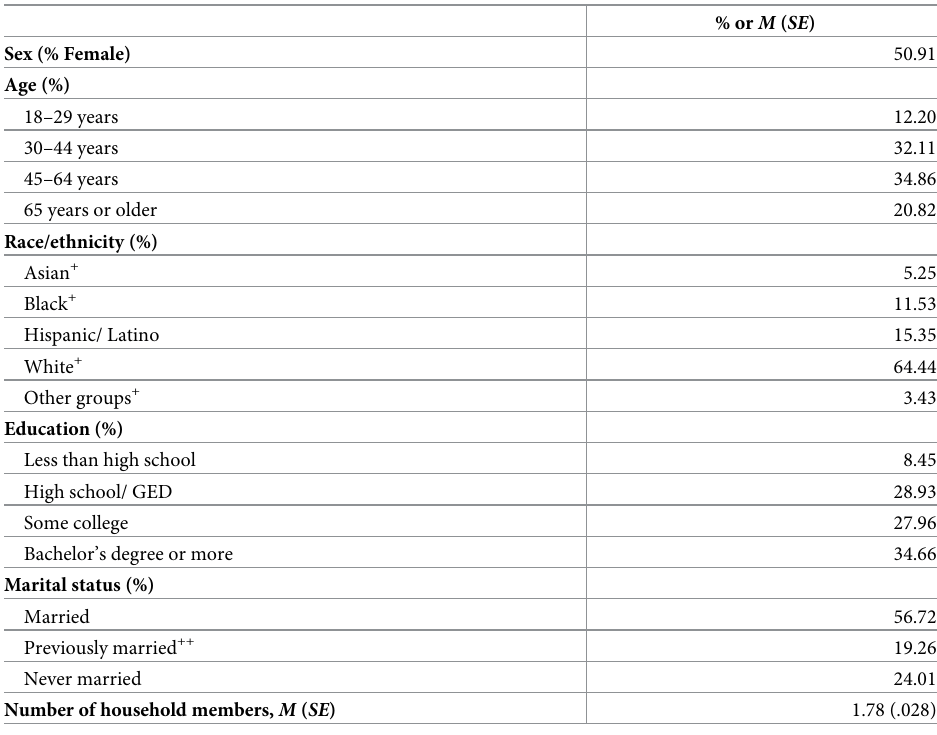
Table 1. Sample socio-demographics at wave 1 ( N =